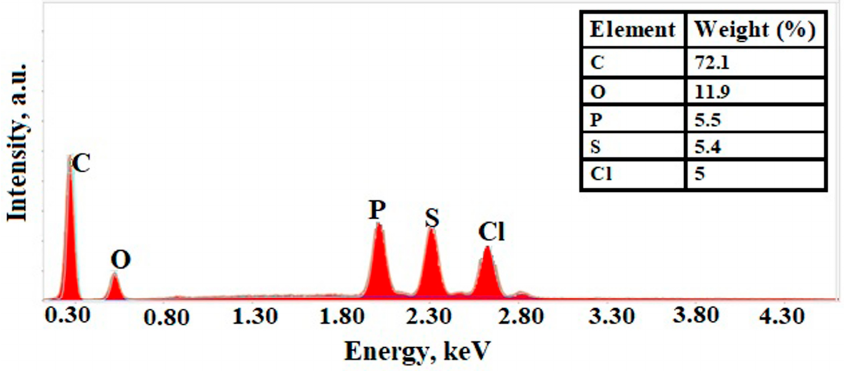
Figure 4. EDX spectra for polysulfone functionalized with triethylphosphonium groups.